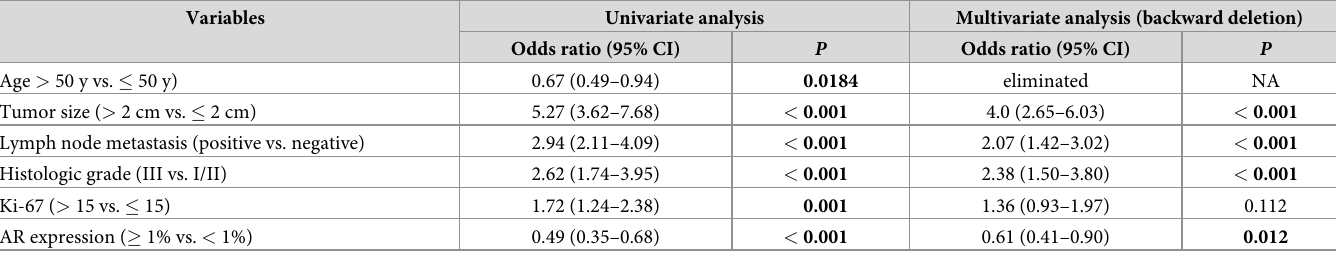
Table 4. Univariate and multivariate analyses for determining SUV max